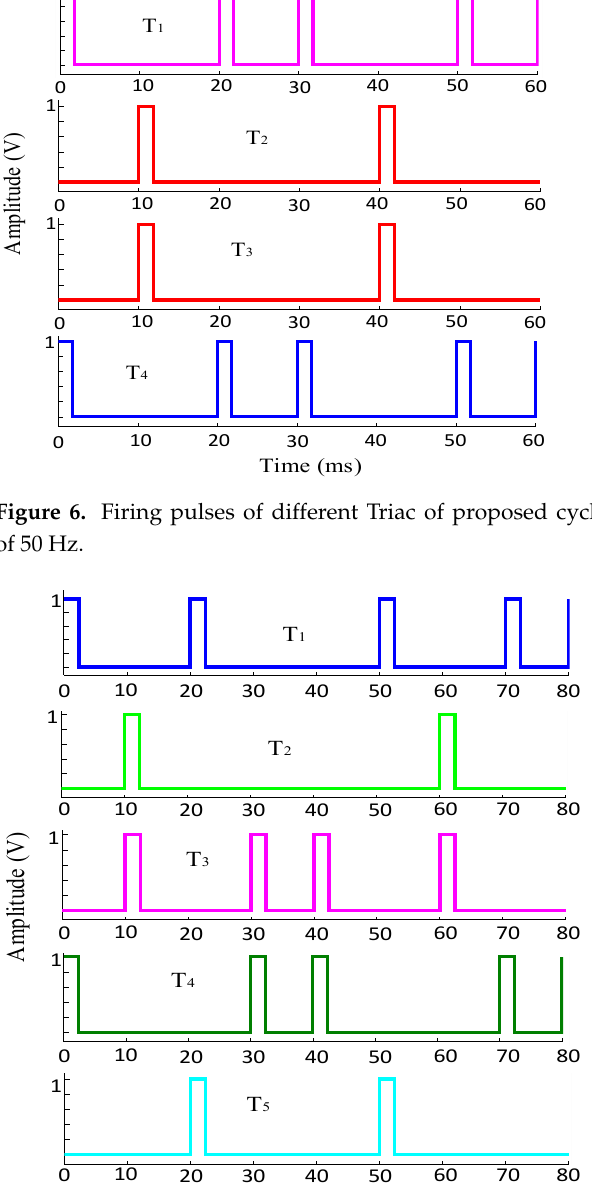
Figure 7. Firing pulses of different Triac of proposed cycloconverter for one − fourth conversion of 50 Hz.